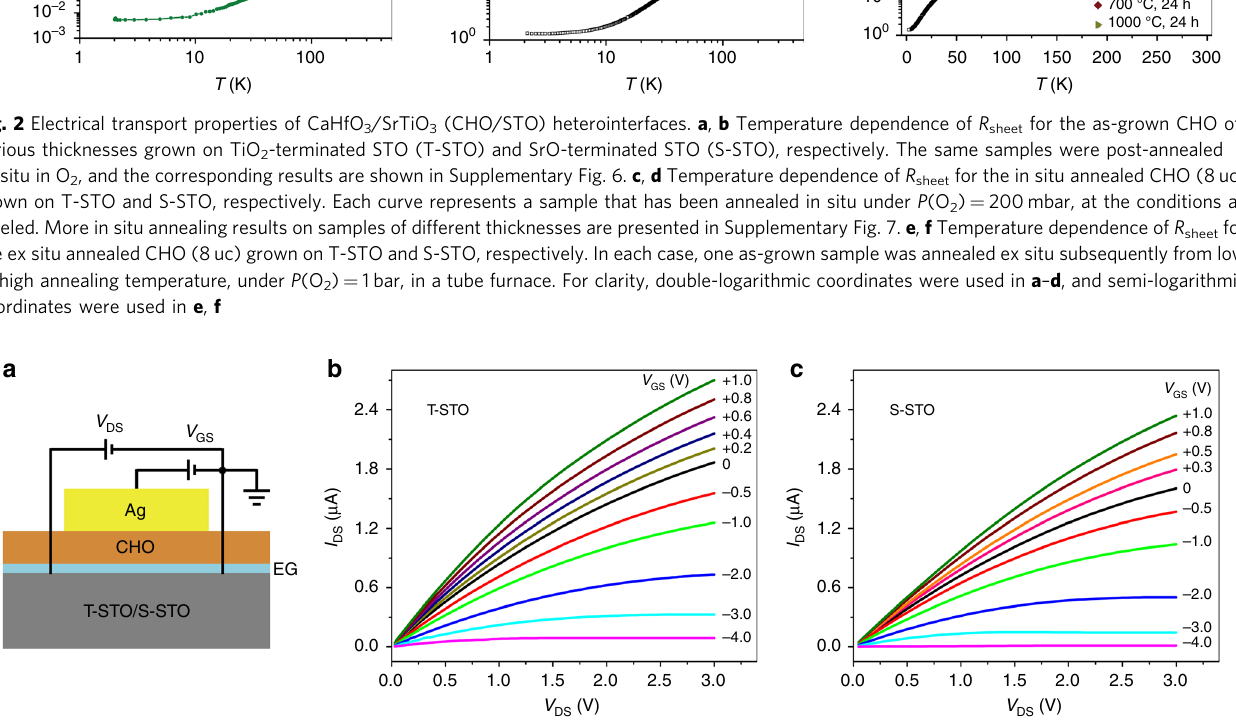
HfO 2 (note that HfO 2 is replacing SiO 2 as the gating and insu- lating material in commercial integrated circuits). Here, we demonstrate that the CHO/STO of both terminations can be used to fabricate fi eld-effect devices. As schematically shown in Fig. 3a, the EG at the CHO/STO heterointerface is used as the drain (D)-source (S) channel, and the epitaxial CHO fi lm as gate dielectrics, for FET operations. The output characteristics, drain-source current ( I DS ) versus drain- source voltage ( V DS ) at different gate voltages ( V GS ), are shown in